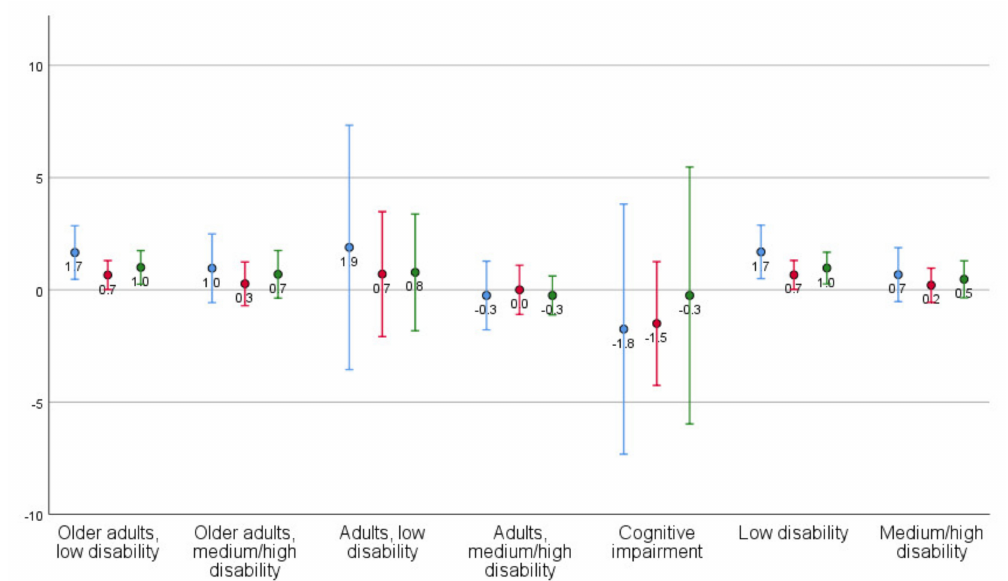
Figure 1. Mean (dots) changes with standard deviation (lines) in ADL dependence, per client profile and aggregated client profiles (blue line = total ADL, red line = P-ADL, green line = I-ADL). Values > 0 indicate decline (i.e., increased dependency) from T1 to T4.